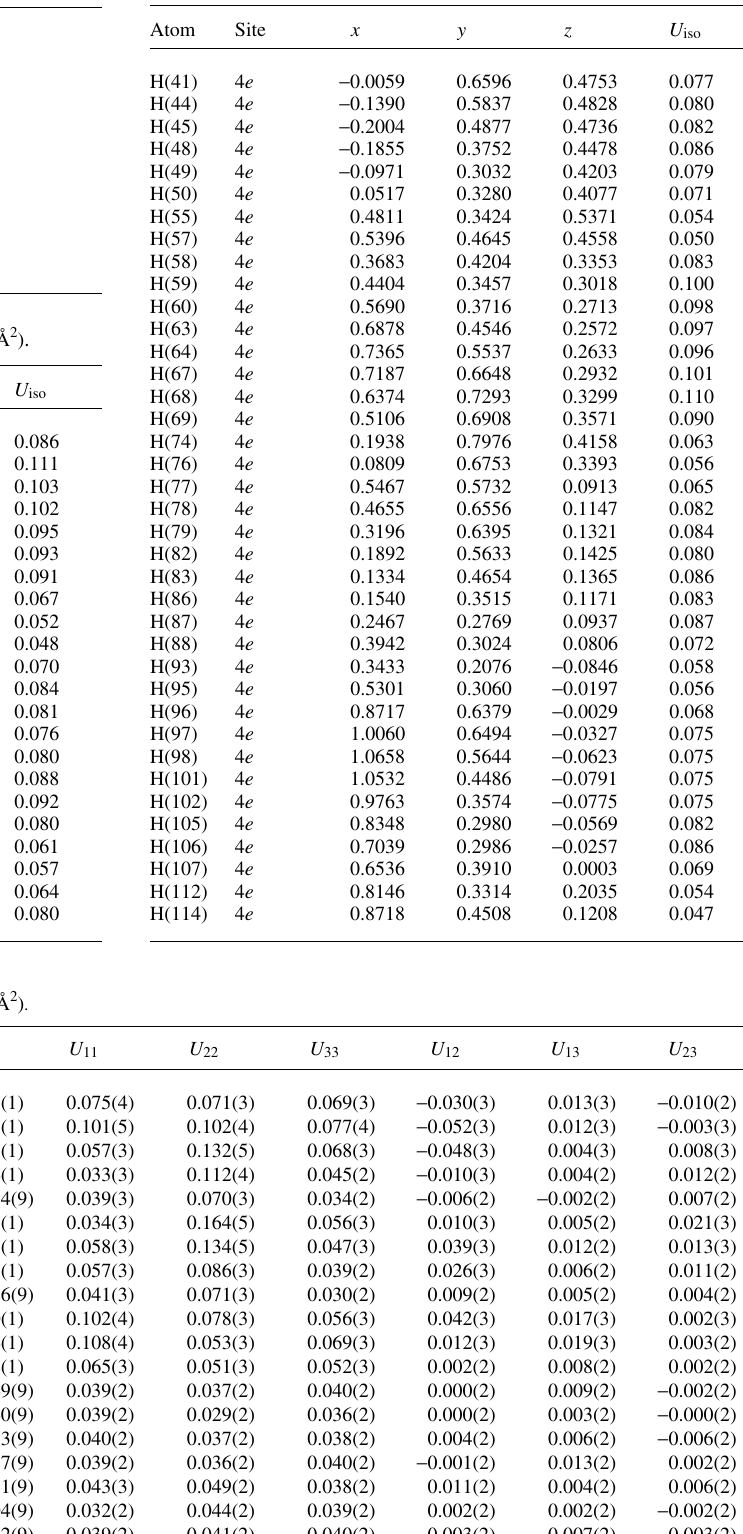
Table 1. Data collection and